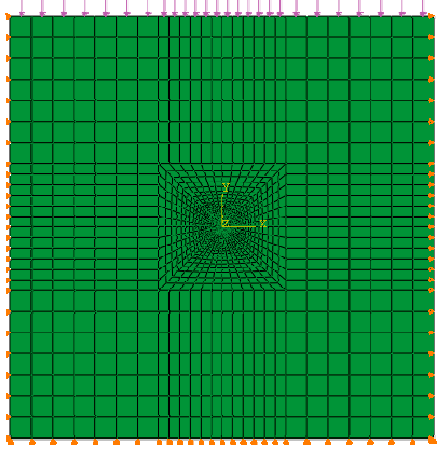
Figure 4. Finite element numerical model.